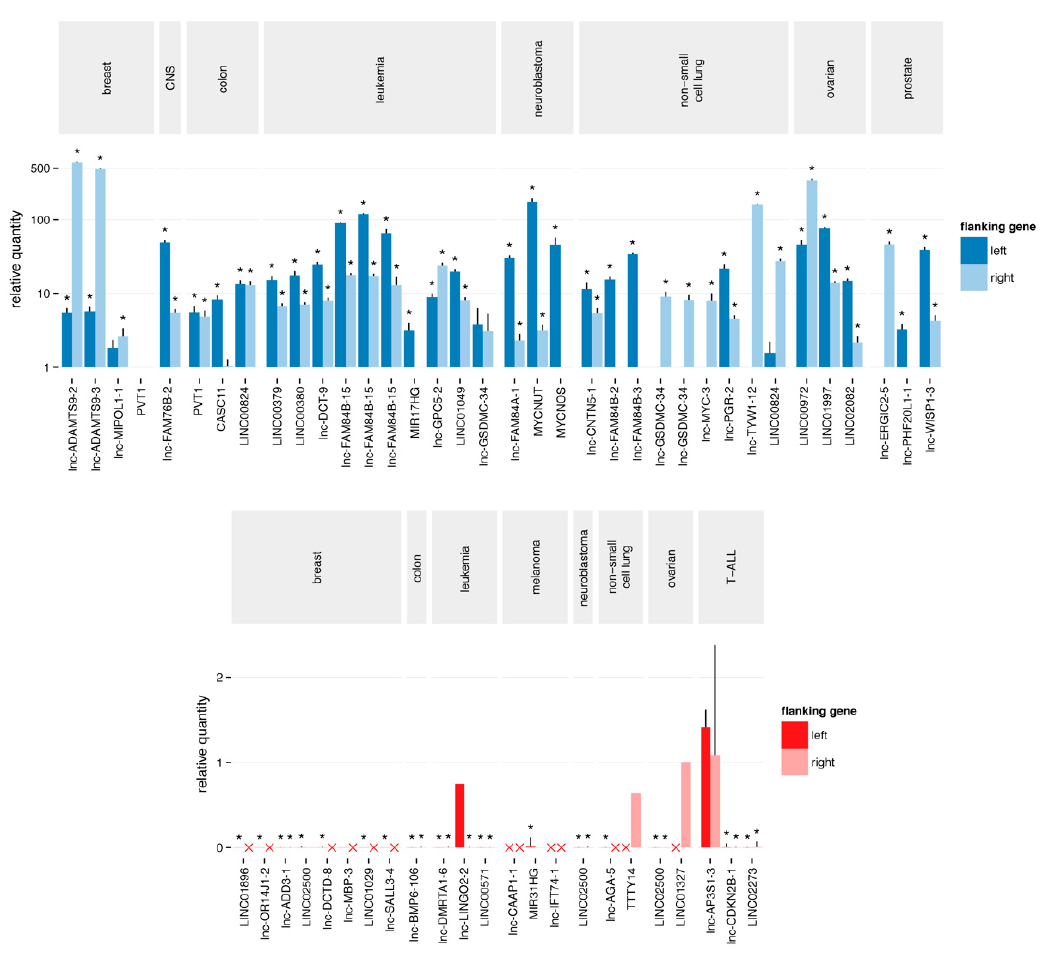
Figure 2. Quantitative polymerase chain reaction validation of the putative focal SCNAs. The Cq value of the aberration is normalized to the Cq value of each of the flanking regions. A copy number gain (blue) is considered as confirmed and focal when the relative quantity to both flanking regions is higher than one. Similarly, a copy number loss (red) is considered as confirmed and focal when the relative quantity to both flanking regions is less than one. Red crosses represent Cq values > 35, corresponding to a homozygous deletion of the flanking regions. Stars represent significant ( p -value < 0.05) differences from